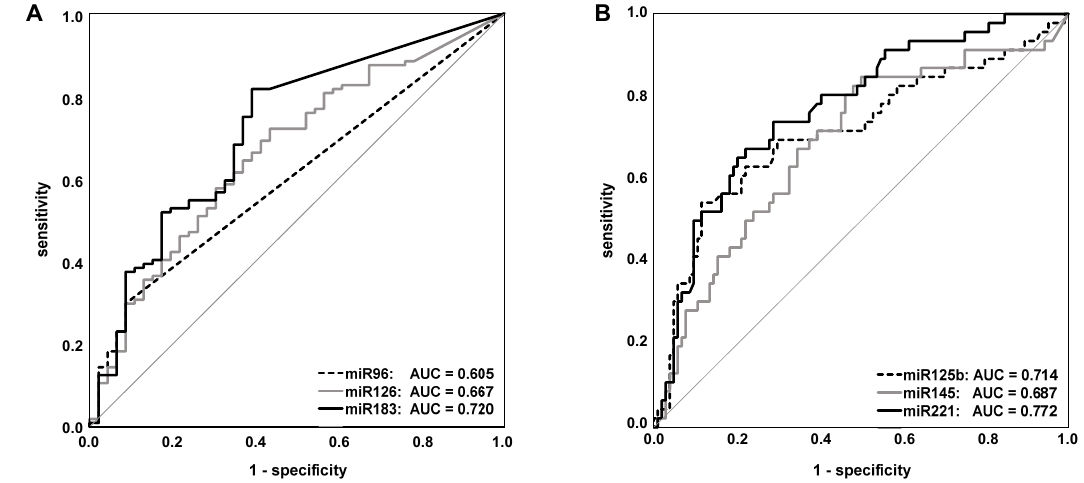
Figure 3. The diagnostic value assessed by ROC curve analysis of the six most promising miRNAs, which were significantly up- (A) or down-regulated (B) in urine sediments from BCa patients in comparison with controls. AUC, area under the curve; ROC, receiver operating characteristic.